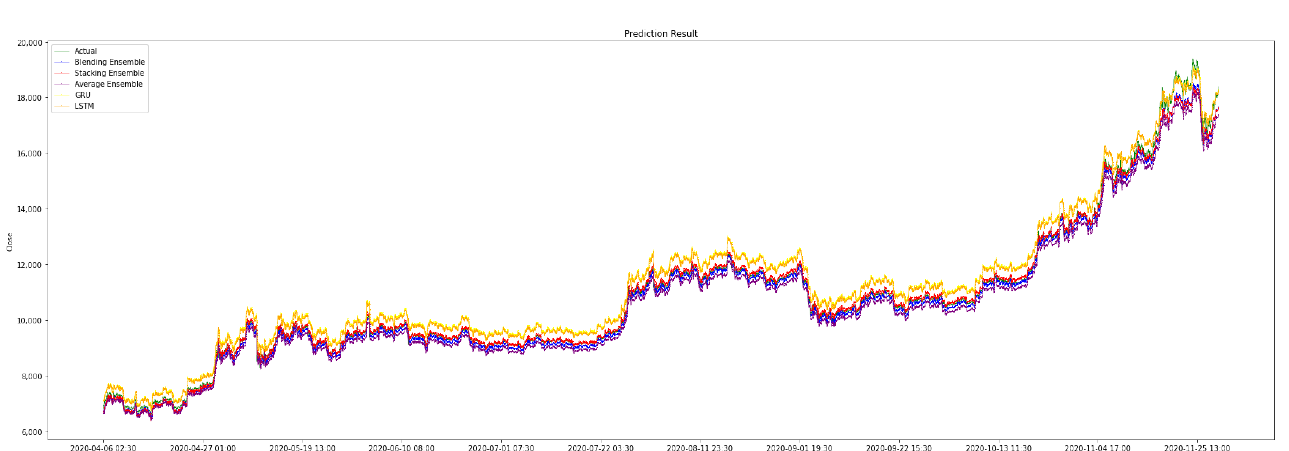
Figure 9. Price + technical indicator + sentiment indicator prediction results of the